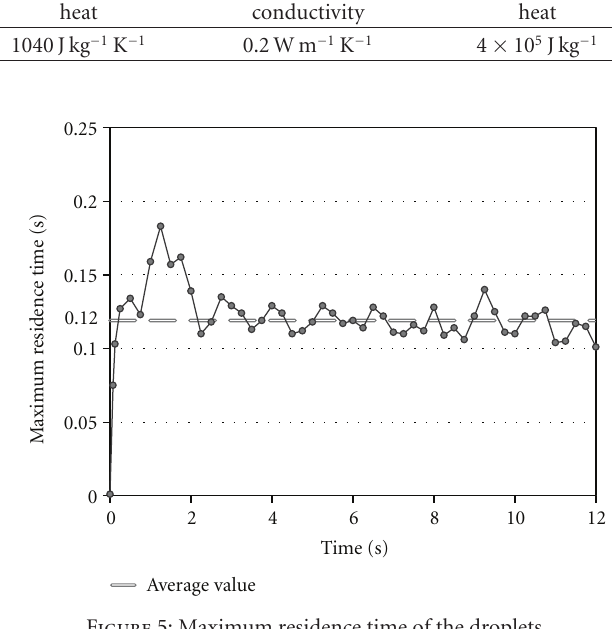
Figure 5: Maximum residence time of the droplets.